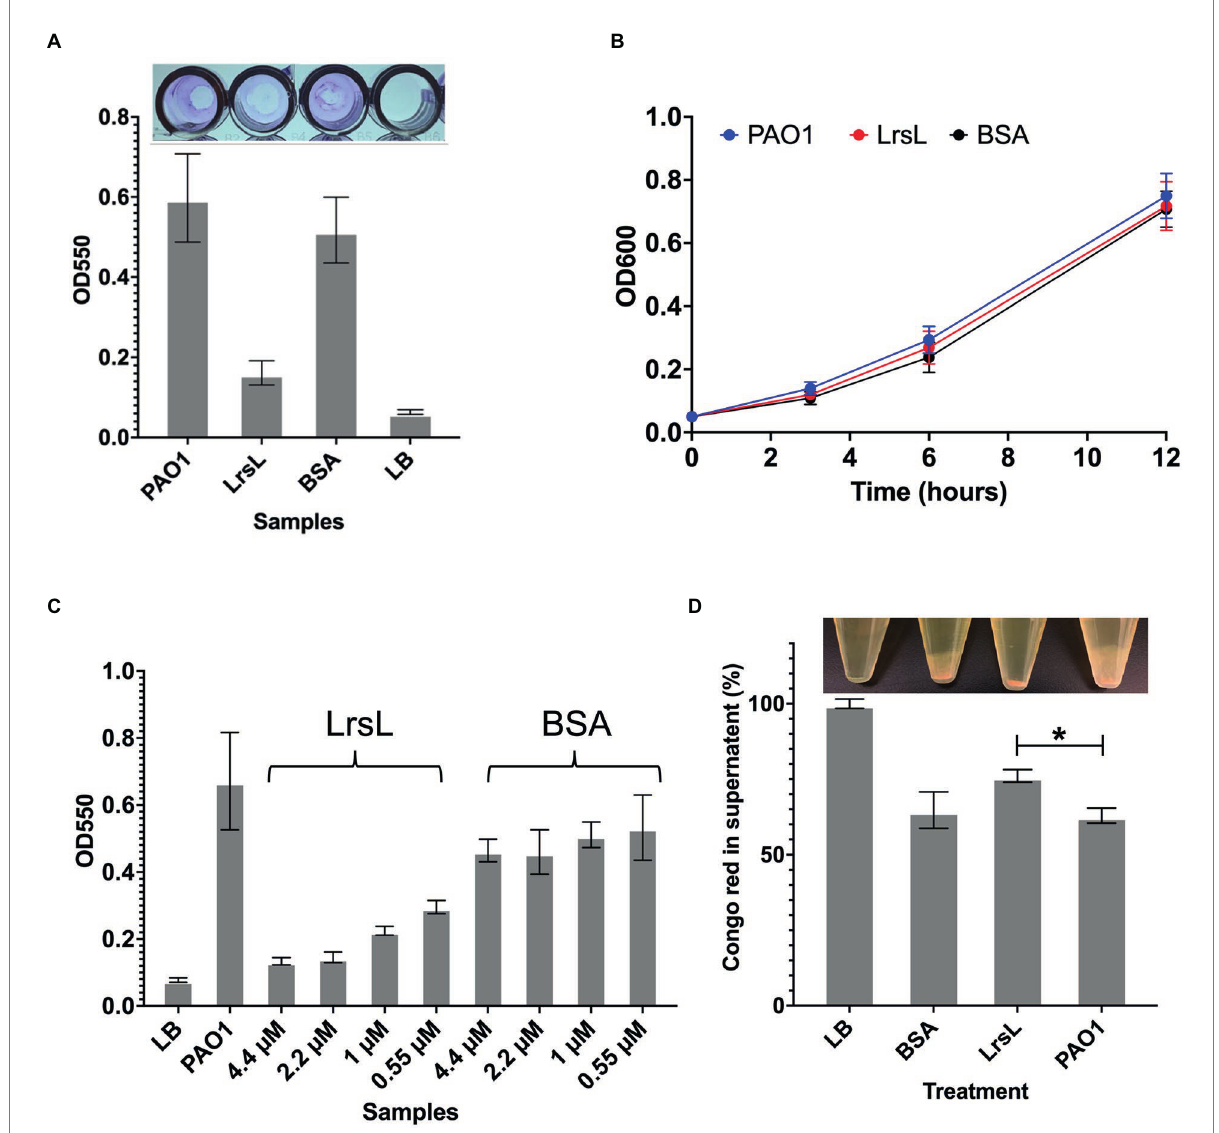
FIGURE 5 LrsL reduces biofilm formation. (A) The upper panel shows the photo of wells with biofilm formed by Pseudomonas aeruginosa PAO1 and various treatments. The lower panel shows the corresponding quantification of biofilms. The y -axis shows absorbance at 550 nm, and the x -axis shows biofilm formed by PAO1(with buffer D) and PAO1 with LrsL, and BSA. Unpaired student’s t -test was applied to measure the significance; value of p < 0.001 are indicated by asterisks. (B) The growth curves of P. aeruginosa (PAO1) and PAO1 treated with LrsL and BSA shows no significant difference. (C) LrsL reduces biofilm formation in a dose-dependent manner. Increasing the dose of LrsL increases the suppression of biofilm formation by P. aeruginosa . The y -axis shows absorbance at 550 nm, and the x -axis shows biofilm formed by PAO1 (with buffer D) and PAO1 treated with various concentrations of LrsL and BSA. The LrsL concentration was increased from 0.55 μ M to 4.43 μ M. As a control, PAO1 was also incubated with similar concentrations of BSA. For all the experiments, LB was used as a negative control. Error bars indicate the standard deviation of three biological replicates (eight wells each). (D) LrsL interferes with Pel production by P. aeruginosa . The upper panel show photographs of blank (LB) and P. aeruginosa cultures incubated with BSA, LrsL, and buffer D (PAO1). The lower panel shows the quantification of Pel using the Congo Red (CR) binding assay. For LB, all the CR remained in the supernatant, represented as 100%. In the presence of LrsL, Pel production was compromised, and more CR remained in supernatant compared to BSA and PAO1. The difference between CR in the supernatant of LrsL-treated and untreated PAO1 was significantly higher as measured by the student’s t -test, shown by an asterisk (value of p = 0.005). Error bars represent the standard deviation of three biological